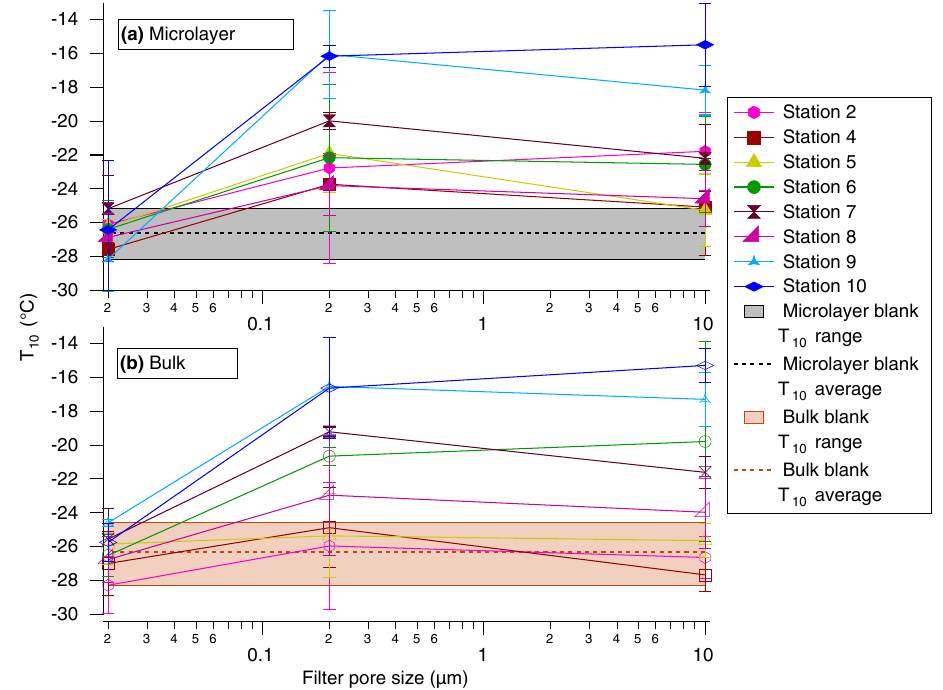
Figure 7. Temperature at which 10% of the droplets froze ( T 10 ) as a function of filter pore size in microlayer samples (a) and bulk sea- water samples (b) . Filter pore sizes were 10, 0.2, and 0.02µm. Error bars are the 95% confidence intervals of the T 10 from three replicate experiments. All data have been corrected for freezing point